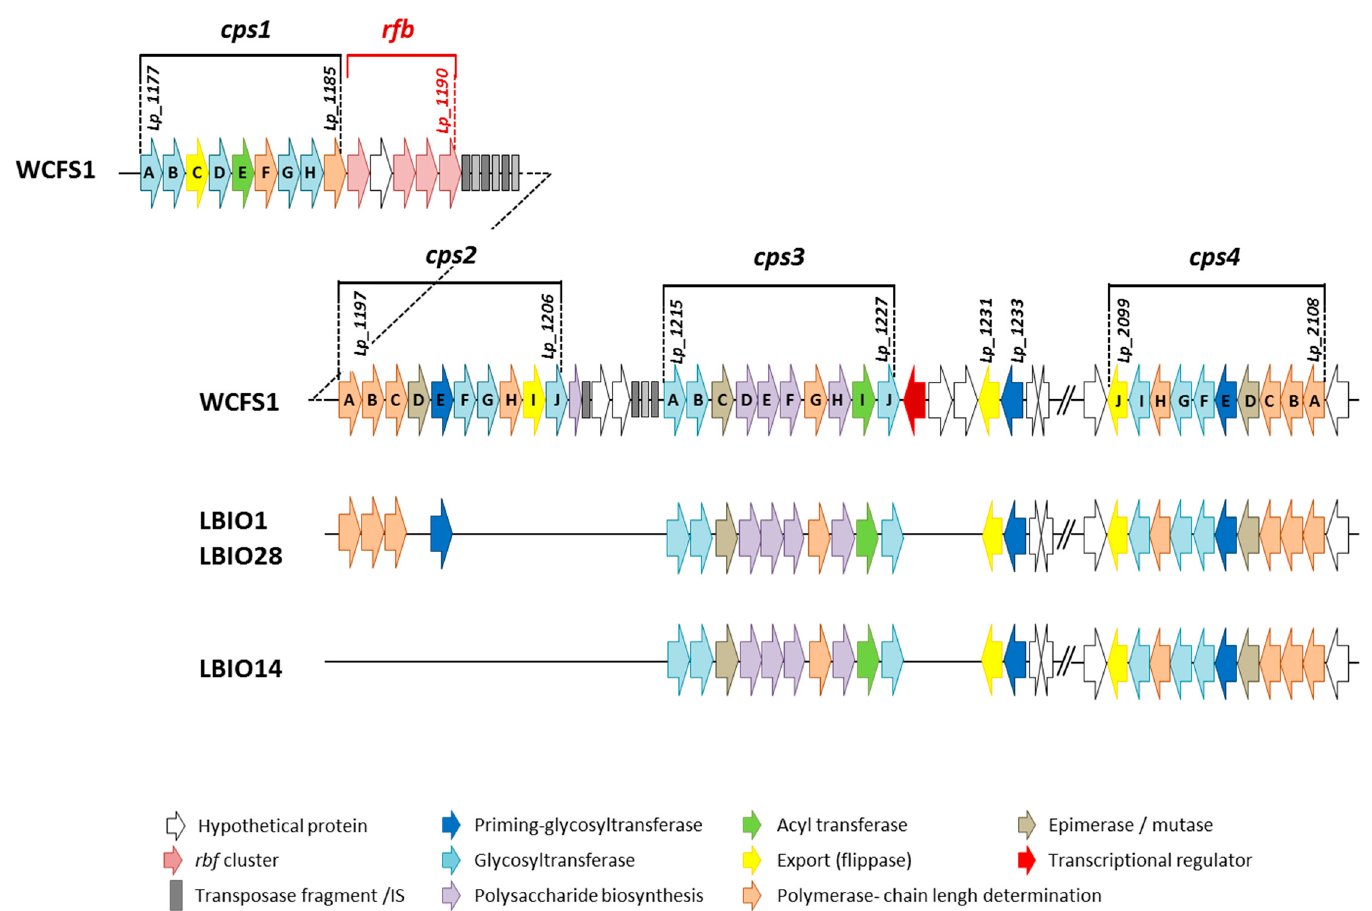
Figure 2. Physical maps of the biosynthetic eps clusters found in the genome (chromosome) of the strains L. plantarum LBIO1, LBIO14 and LBIO28 in comparison with the reference strain WCFS1. The length of the arrow is not proportional to the length of the predicted open reading frame (ORF). For detailed description of the genes and percentages of homology, see supplementary file 1.